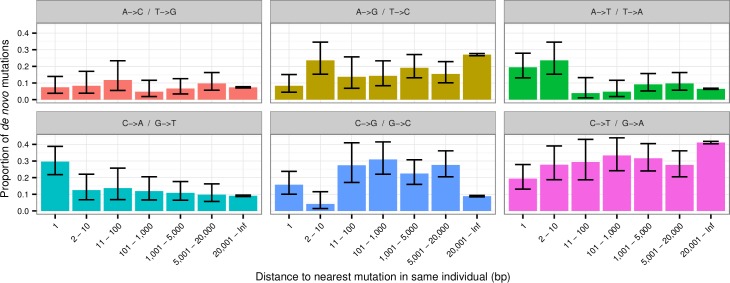
Distribution of mutation types.The relative distribution of different types of mutations stratified by the distance to nearest mutation in the same individual. The error bars are 95% confidence intervals.